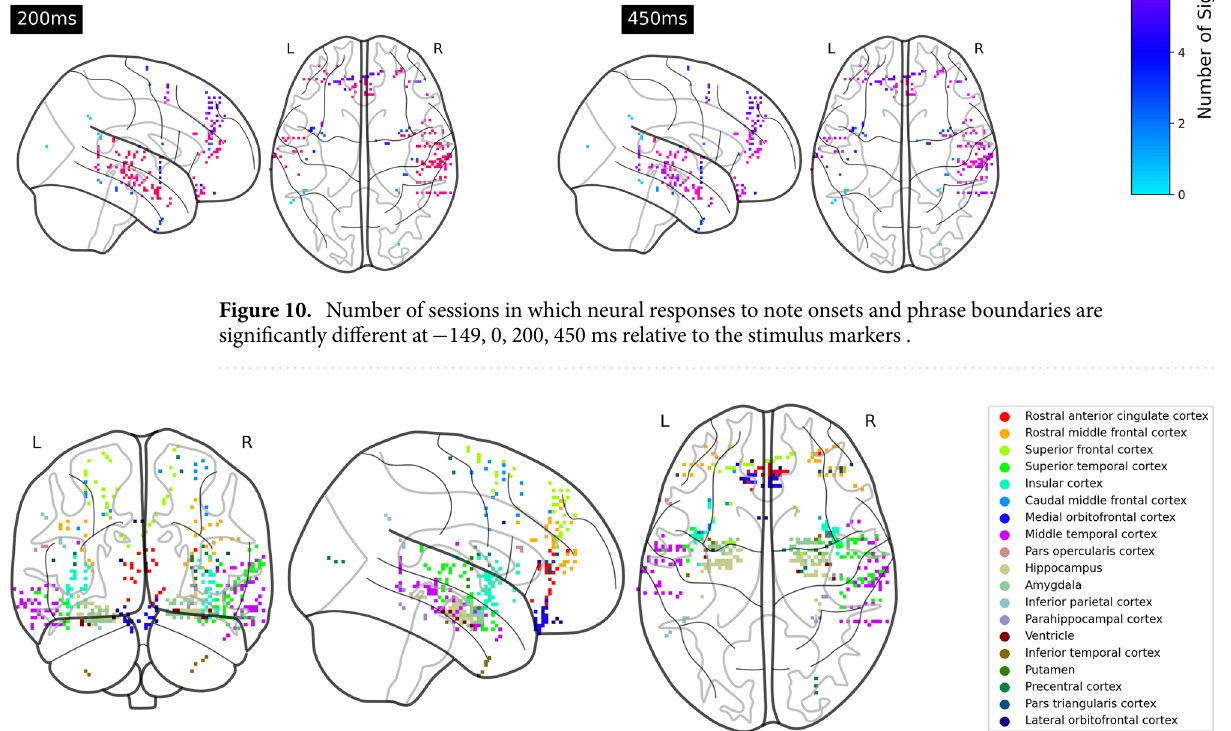
Figure 11. The location of electrodes within each subregion